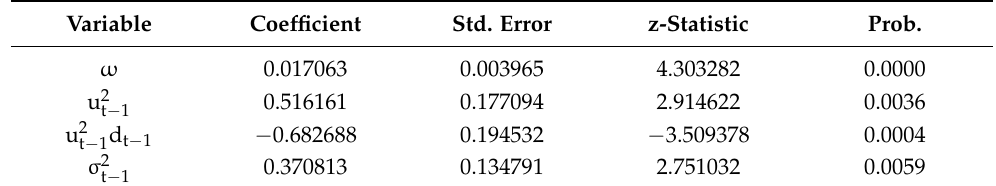
Table 7. The TARCH estimation result of oil price volatility from aggregate demand shock and